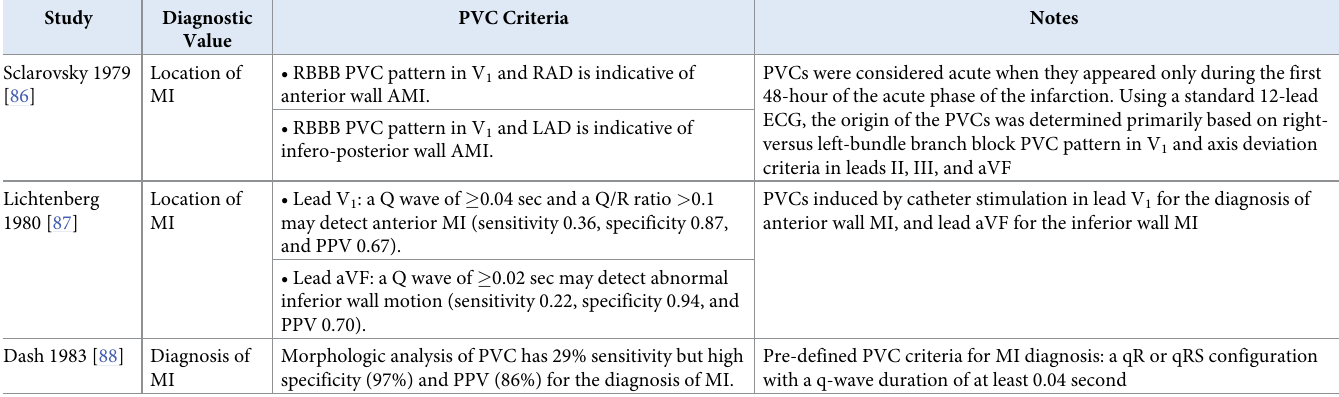
Table 3. Diagnostic value of premature ventricular complexes (PVCs) during the early phase of acute myocardial